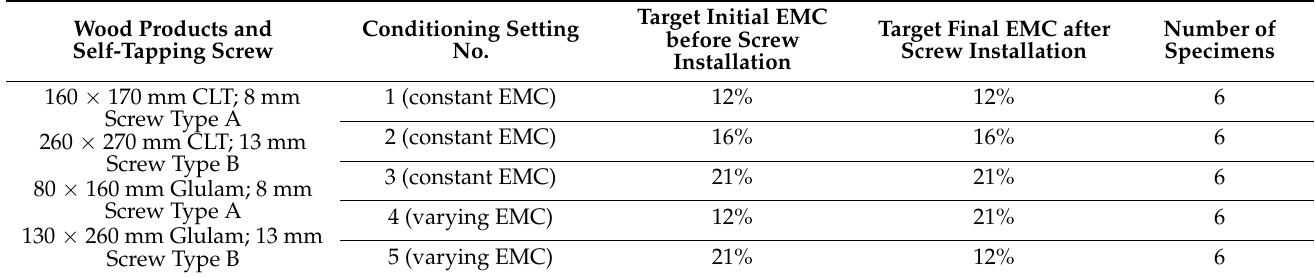
Table 5. Different specimen groups and their conditioning EMCs in the two stages used in the finite element